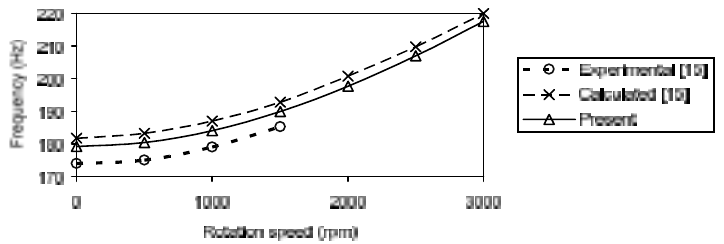
Fig. 5. First harmonic frequencies of blade in terms of the rotation